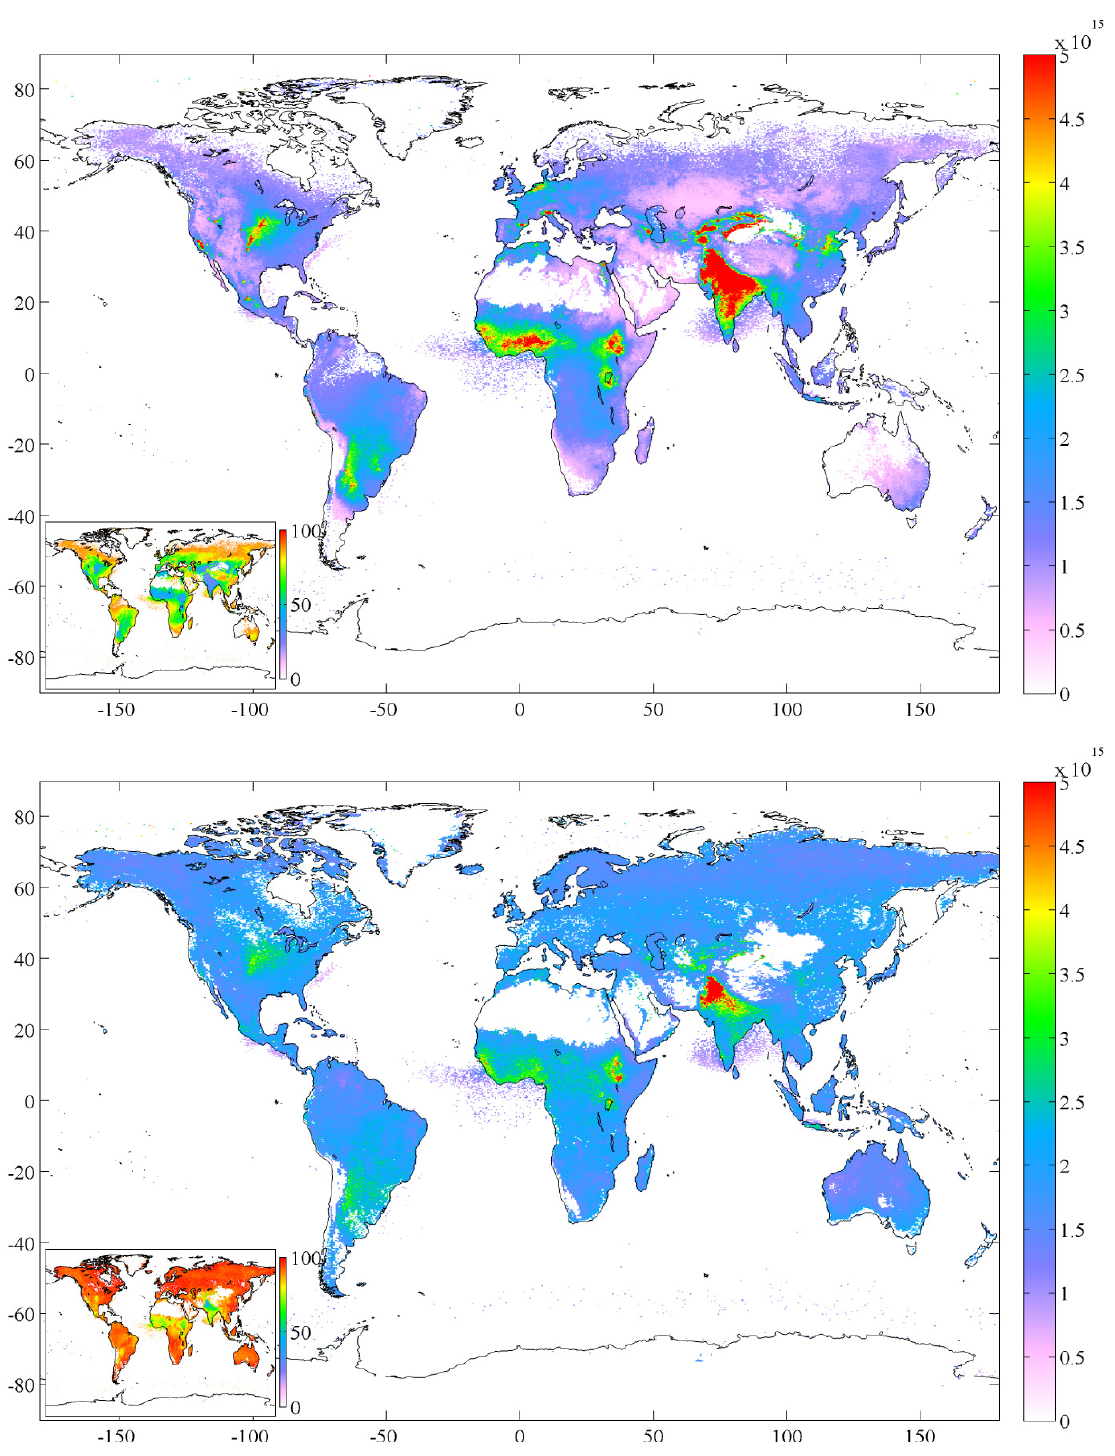
Fig. 11. NH 3 total columns (moleccm − 2 ) and relative error (bottom-left inset, %) distributions for five years of IASI measurements (1 November 2007 to 31 October 2012), in 0.25 ◦ × 0.5 ◦ cells for the morning (top panel) and evening (bottom panel) overpasses. The NH 3 distributions are a mean of all measurements within a cell, weighted by the absolute retrieval error following Eq. (3). The error distri- butions are a weighted mean of the absolute error of all observations within a cell following Eq. (4) and divided by the NH 3 total columns to provide an error distribution in